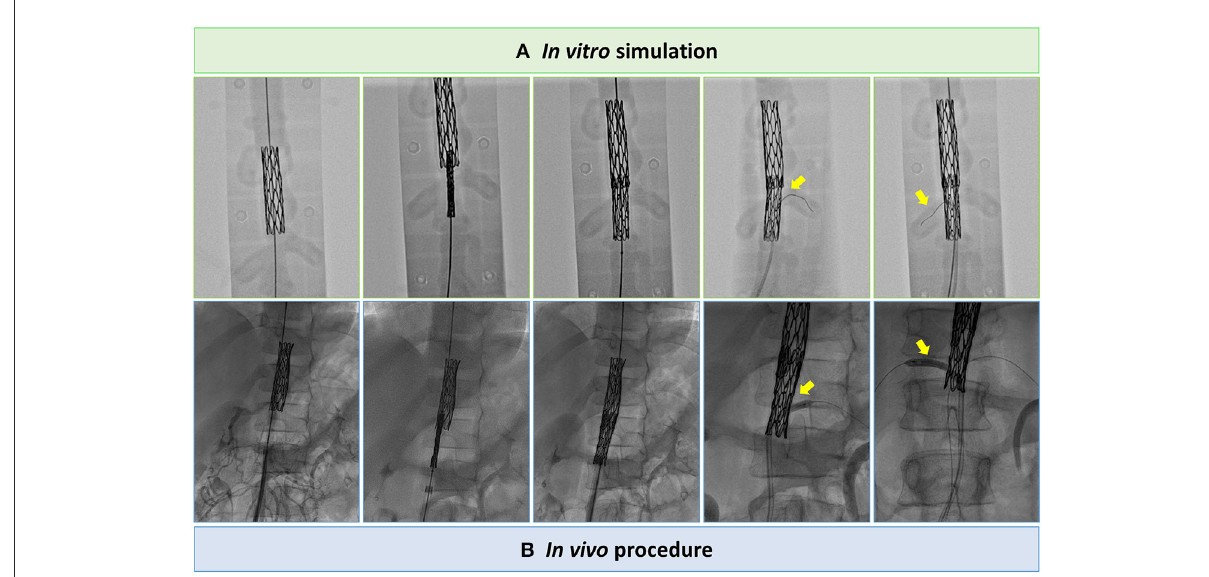
FIGURE3 Still angiographic frames of the tests on the in vitro planning platform (A) to assess procedure feasibility and procedural steps performed in vivo (B) , i.e., CP stents implantation with partial overlap in pre- and infra-renal segments and bilateral renal angioplasty across the frames of the CP stent.